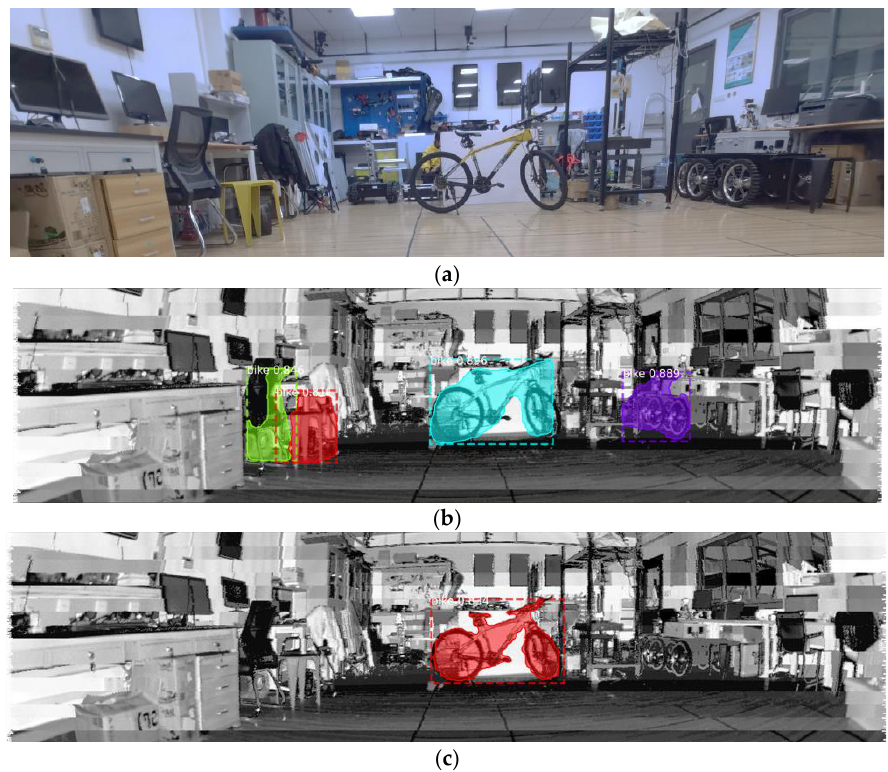
Figure 13. Bike segmentations using the Mask-RCNN before and after the transfer learning in the indoor scene: ( a ) the RGB image in the indoor scene; ( b ) segmentation of bike before transfer learning; ( c ) segmentation of bike after transfer learning.